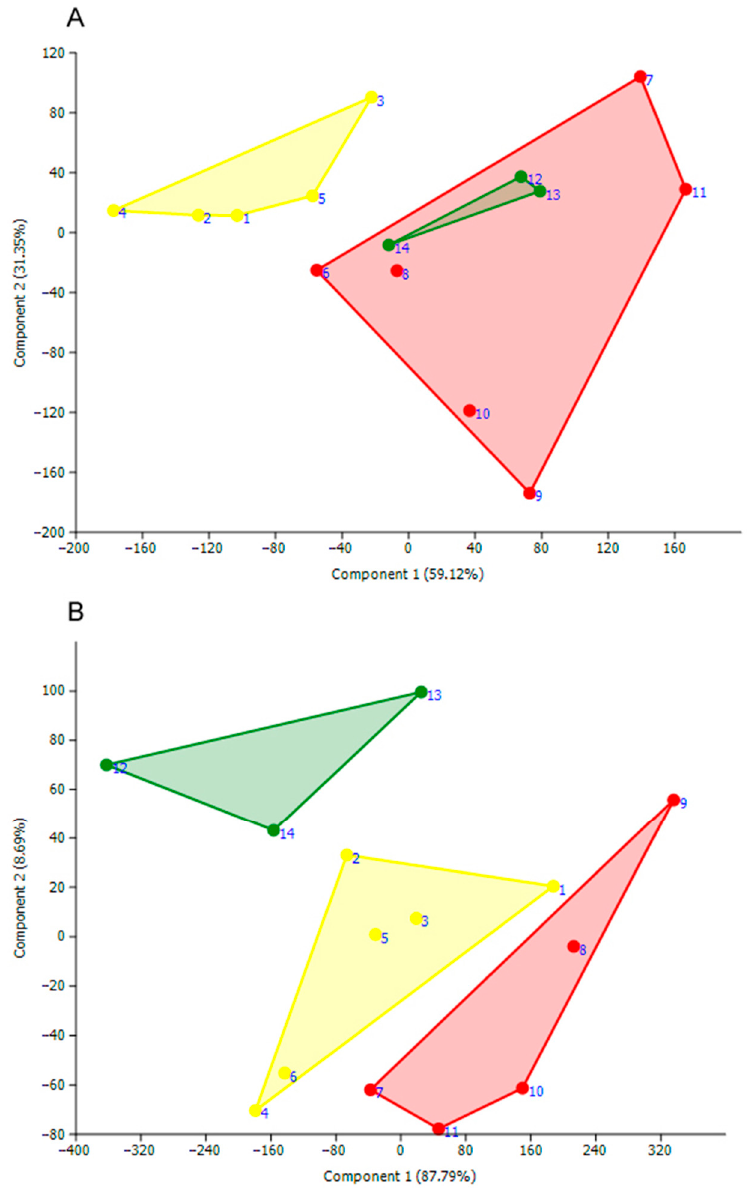
Figure 8. PCA ordination plot of the three new mite species according to the length values of 22 morphological parameters: U . ( My .) savadiensis subgen. and sp. nov. (yellow), U . ( My .) generosa sp. nov. (red), and U . ( My .) trapezidens (green) (see Supplementary Table S2 for detail). ( A ) males; ( B ) females. Numbers near points are serial numbers of measured mites.